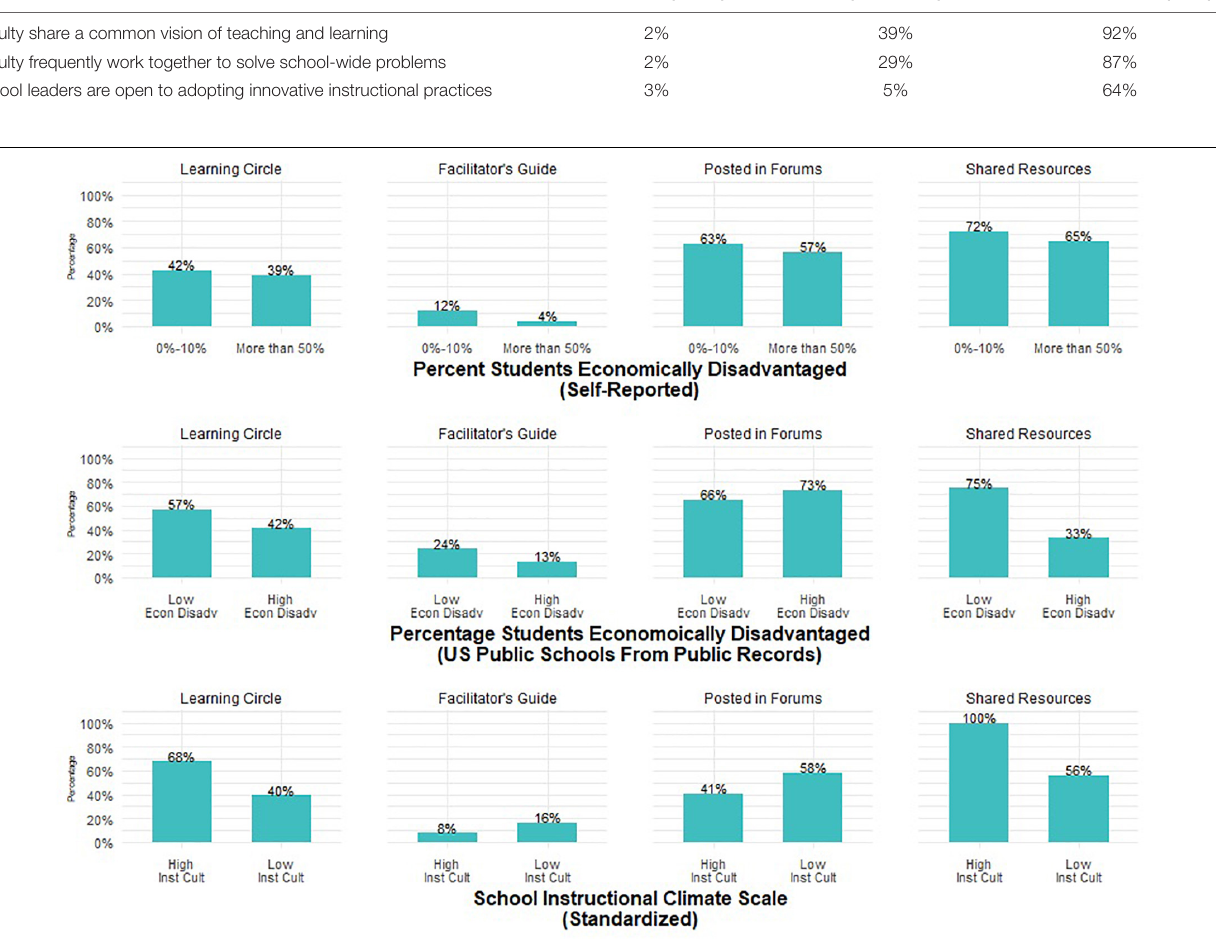
Middle range One standard deviation (–1.0 to 1.0) above the mean ( > 1.0)